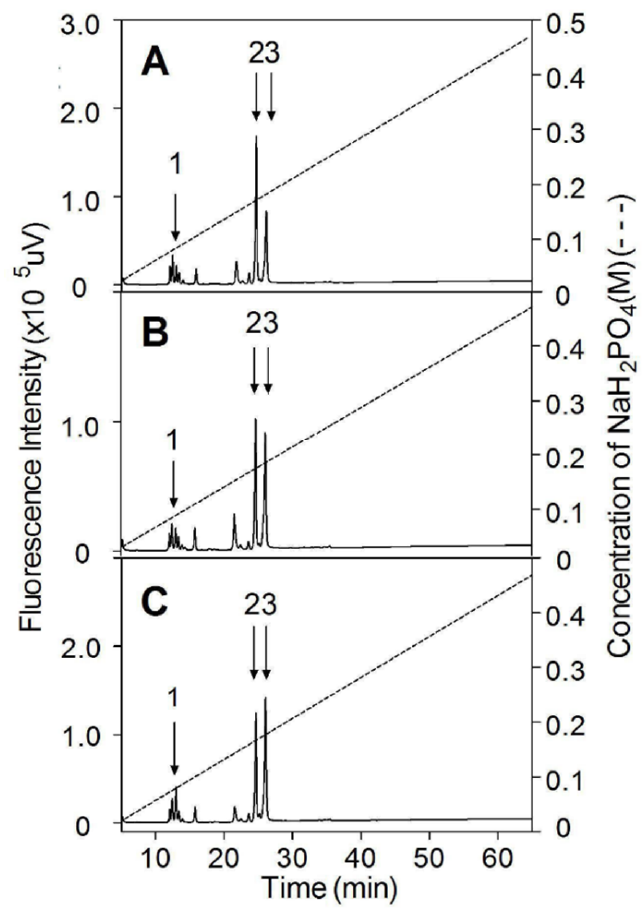
Figure 4. Disaccharide composition analysis by anion-exchange HPLC. CS (2 µ g) from the cartilage of head ( A ), backbone ( B ), or fins ( C ) were digested with CSase ABC, labeled by 2-AB, and analyzed by an anion-exchange HPLC column with a fluorescence detector. All samples were analyzed by HPLC on a YMC-Pack PA-G column using a NaH 2 PO 4 gradient (indicated by the dashed line). The elution positions of authentic 2-AB-labeled unsaturated disaccharides are indicated by arrows. 1, ∆ 4,5 HexUA α 1-3GalNAc; 2, ∆ 4,5 HexUA α 1-3GalNAc(6S); 3, ∆ 4,5 HexUA α 1-3GalNAc(4S). Table 3. The Disaccharide Compositions of CS Preparations from Chinese Sturgeon Cartilage. CS Samples SHCS